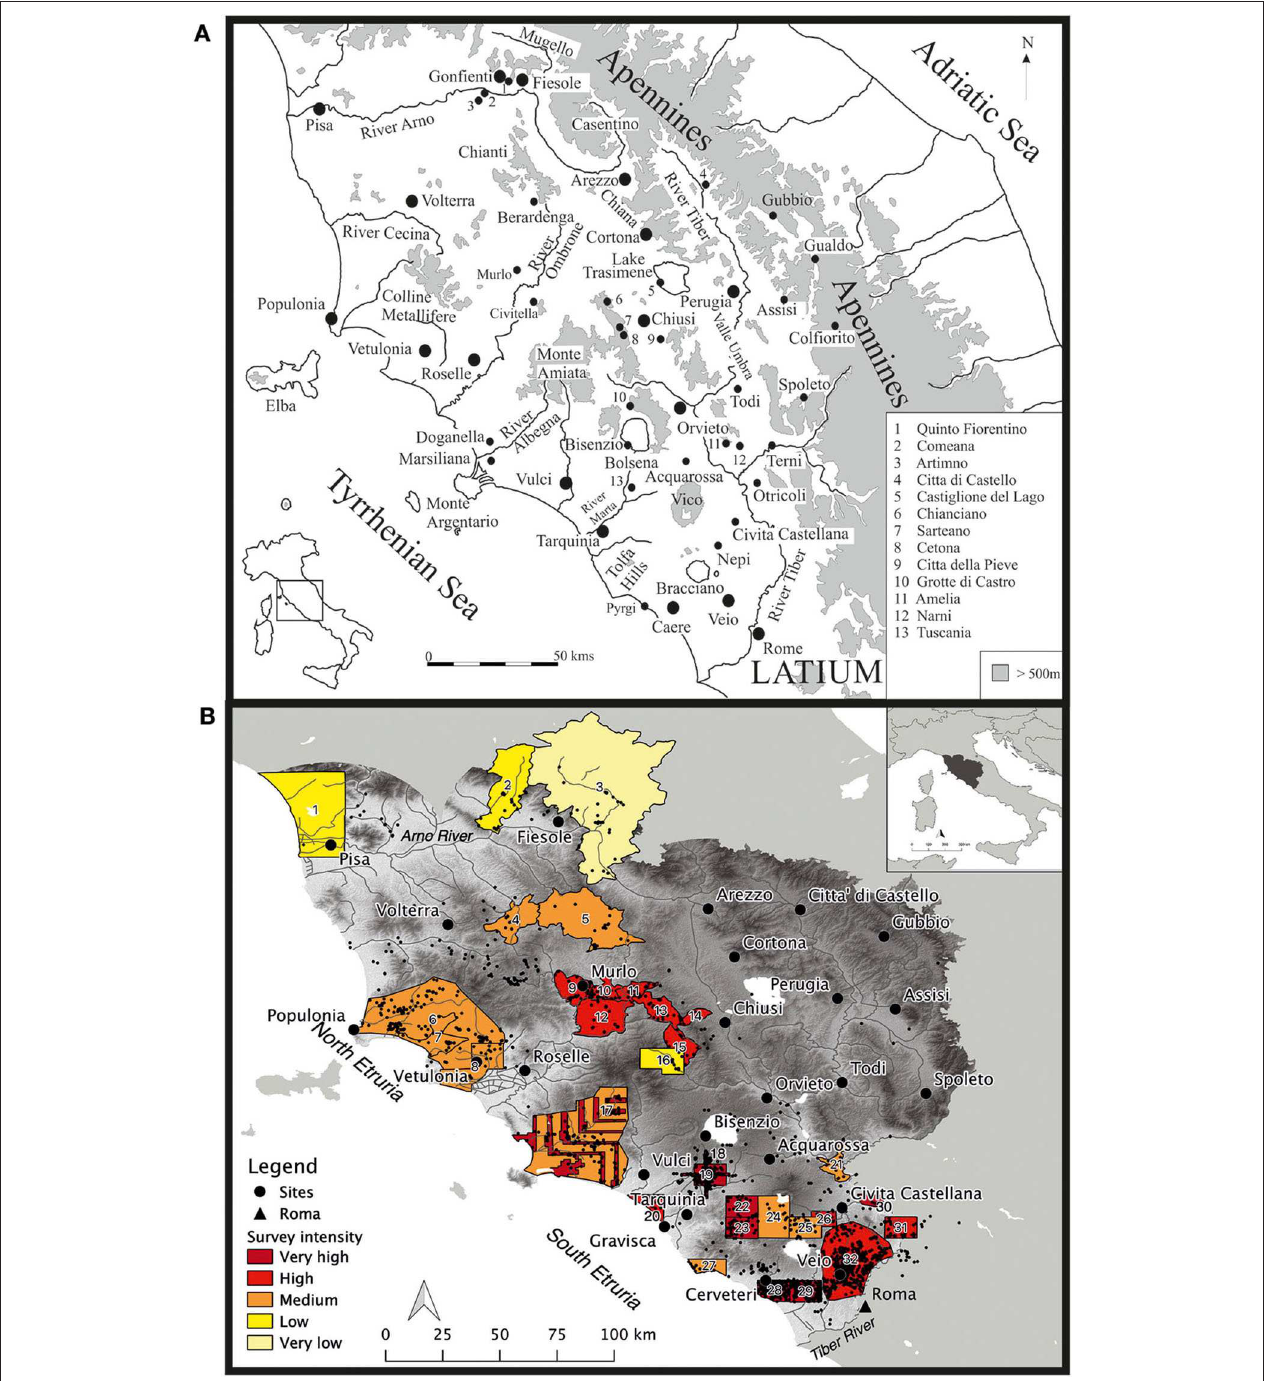
FIGURE 1 | (A) Map illustrating the location of Etruria and the places and regions mentioned in the text. (B) The region of Etruria, showing the survey zones and the recovered rural settlement. The numbered surveys are indicated as follows: (1) Neppi Modona (1953); (2) Perazzi and Poggesi (2011); (3) Chellini (2012); (4) Valenti (1999) ; (5) Valenti (1995); (6) unpublished, courtesy of Di Paola; (7) Cucini (1985); (8) Curri (1978); (9) Campana (2001); (10) Cenni (2010); (11) Felici (2012); (12) Campana (2013); (13) Felici (2004); (14) Paolucci and Francovich (2007); (15) Botarelli (2004); (16) Cambi (1996); (17) Carandini et al. (2002); (18) Quilici Gigli (1970); (19) unpublished, courtesy of (Barker and Rasmussen, 1998); (20) Corsi (2000); (21) Nardi (1980); (22) Quilici Gigli (1976); (23) Hemphill (2000); (24) Andreussi (1977); (25) Morselli (1980); (26) Rajala (2013); (27) Gianfrotta (1972); (28) Enei (2001); (29) Tartara (1999); (30) Verga (2006); (31) Muzzioli (1980); (32) Patterson et al. (2020).